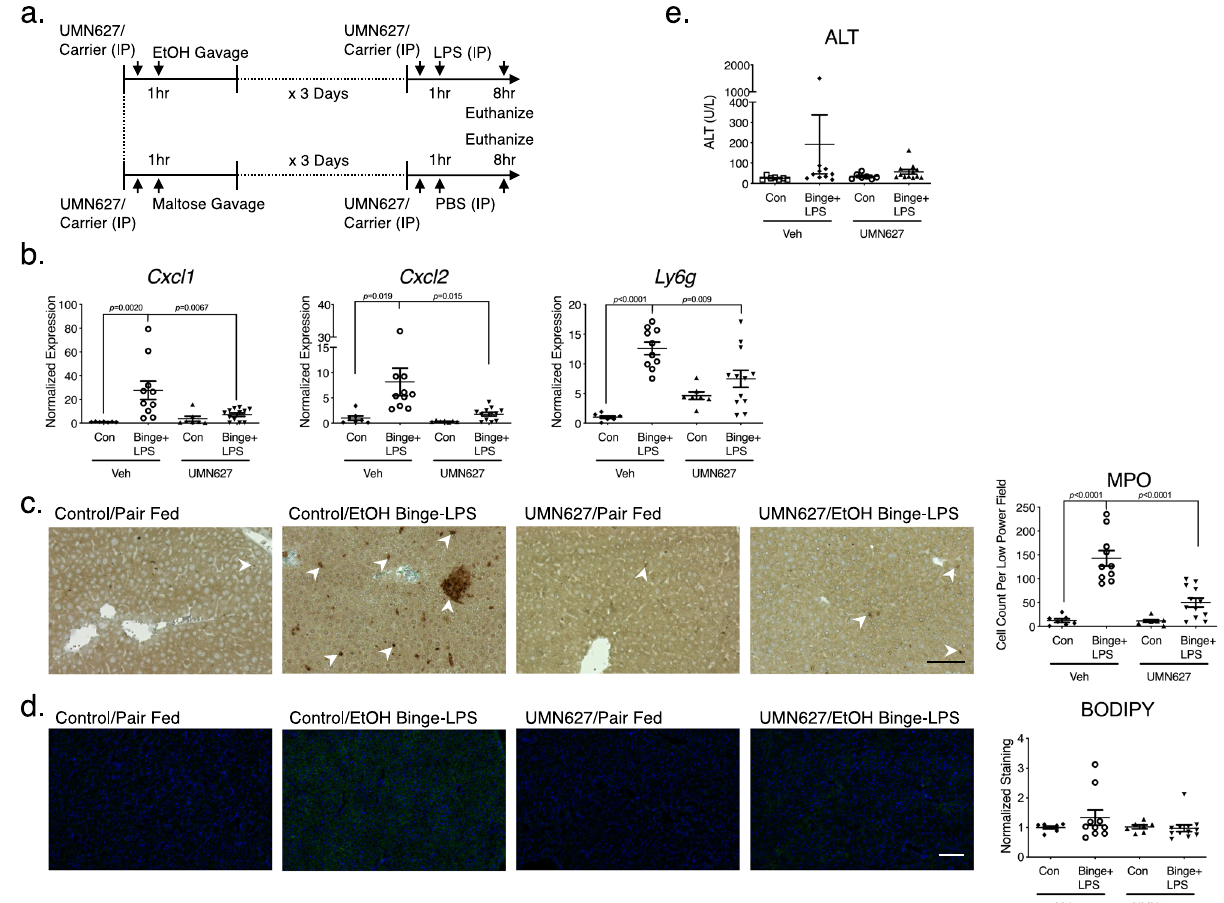
Fig. 7 Bromodomain inhibitor UMN627 attenuates liver CXCL production and neutrophil in fi ltration in an alcohol binge/LPS model. a Schematic of alcohol binge/LPS model protocol. Mice underwent once-daily gastric gavage with alcohol or maltose dextran for 3 days. A subset of mice also received IP injection of UMN627. Alcohol-gavaged mice also received IP injection of LPS on day 4, 8 h before sacri fi ce ( n = 7 Control/Veh, n = 10 Binge + LPS/Veh, n = 7 Control/UMN627, n = 12 Binge + LPS/UMN627, same n for remaining panels of this fi gure). b qPCRs demonstrated CXCL chemokine and neutrophil marker Ly6g expression elevation with alcohol/LPS treatment. This response was attenuated by UMN627. Expression levels were normalized to the average expression of maltose gavaged control mice. c IHC for MPO is shown, with a number of neutrophils per low power fi eld on the y-axis. The experiment was repeated with similar results. d Frozen section of mouse liver was stained with BODIPY 493/503 (green) and DAPI was used to stain nuclei (blue). The experiment was repeated with similar results. e Serum ALT levels did not show statistical differences among various groups. For all analyses, two-way ANOVA was performed on normalized expression values for qPCRs, cell counts for IHC staining, normalized quanti fi cation of BODIPY 493/503 staining, or ALT values, with post hoc Tukey ’ s multiple comparison correction. Data represented as mean ±